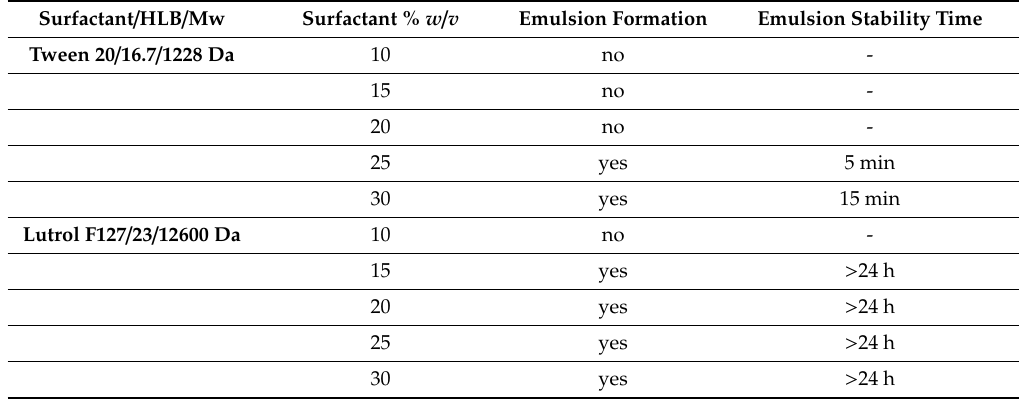
Table 1. Preliminary studies for high internal phase emulsion (HIPE) formation and stability of HIPEs from isopropyl myristate as the oil phase and o / w v / v ratio of 80%, using surfactants with di ff erent Hydrophilic Lipophilic Balance (HLB) and molecular weights